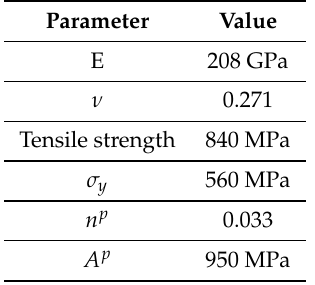
Table 2. Derived material